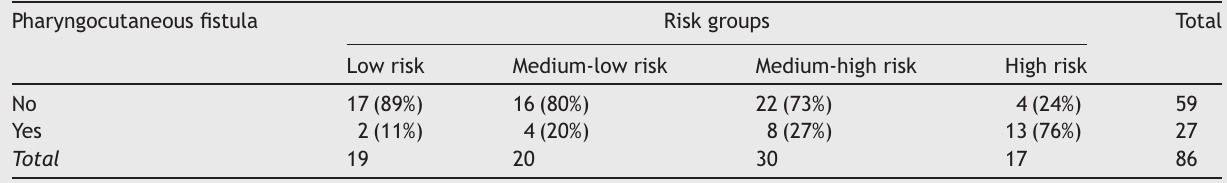
Risk stratification of developing fistula pharyngocutaneous for the